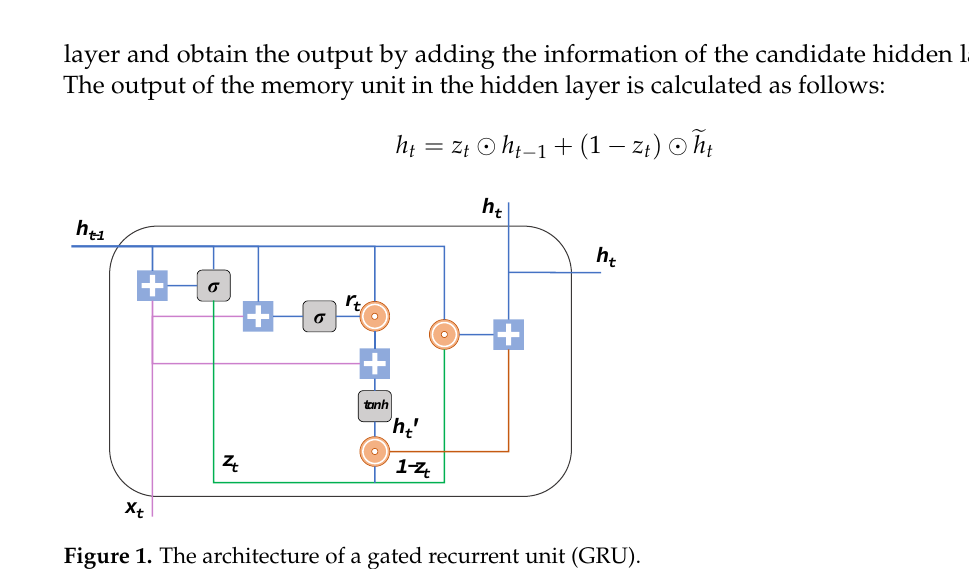
Figure 1. The architecture of a gated recurrent unit (GRU).